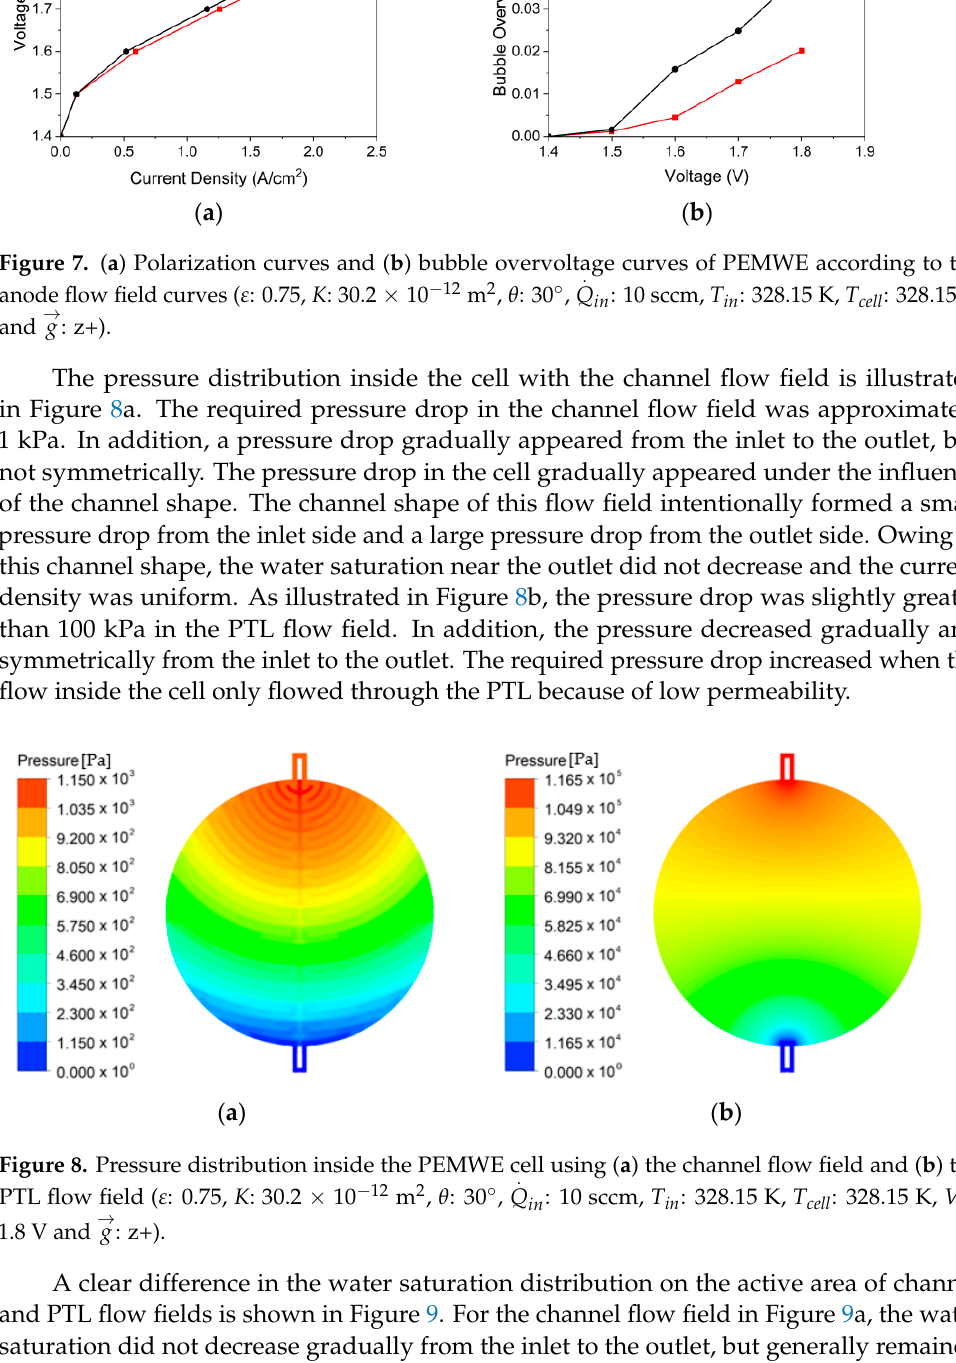
. Q in : 10 sccm, T in : 328.15 K, T cell : 328.15 K,